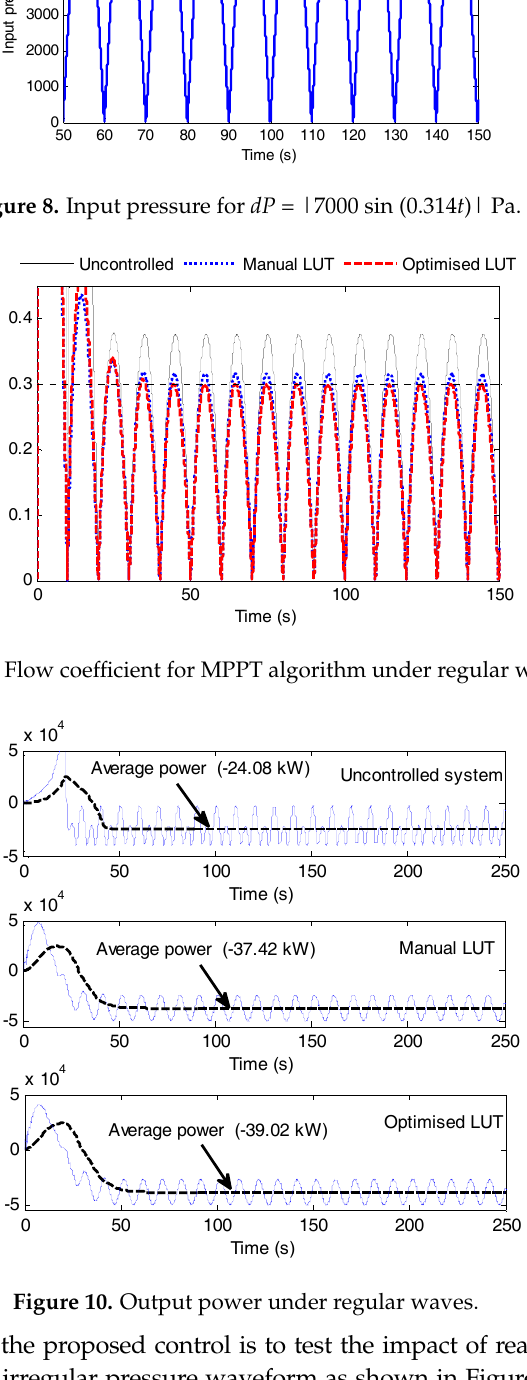
Figure 10. Output power under regular waves.